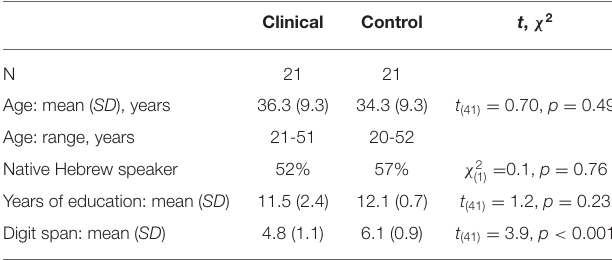
TABLE 1 | Participants’ background